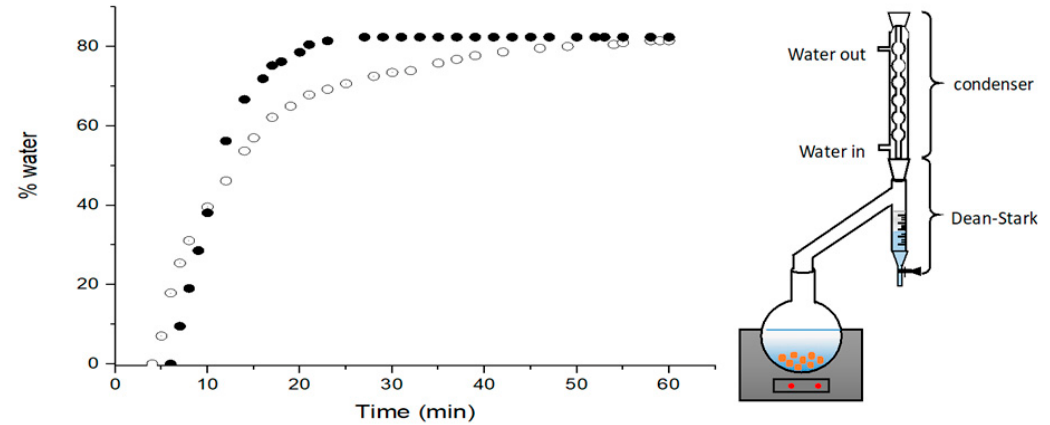
Figure 4. Water distillation kinetics of fresh carrots via toluene ( ◦ ) and p -menthane ( • ) using Dean– Stark.